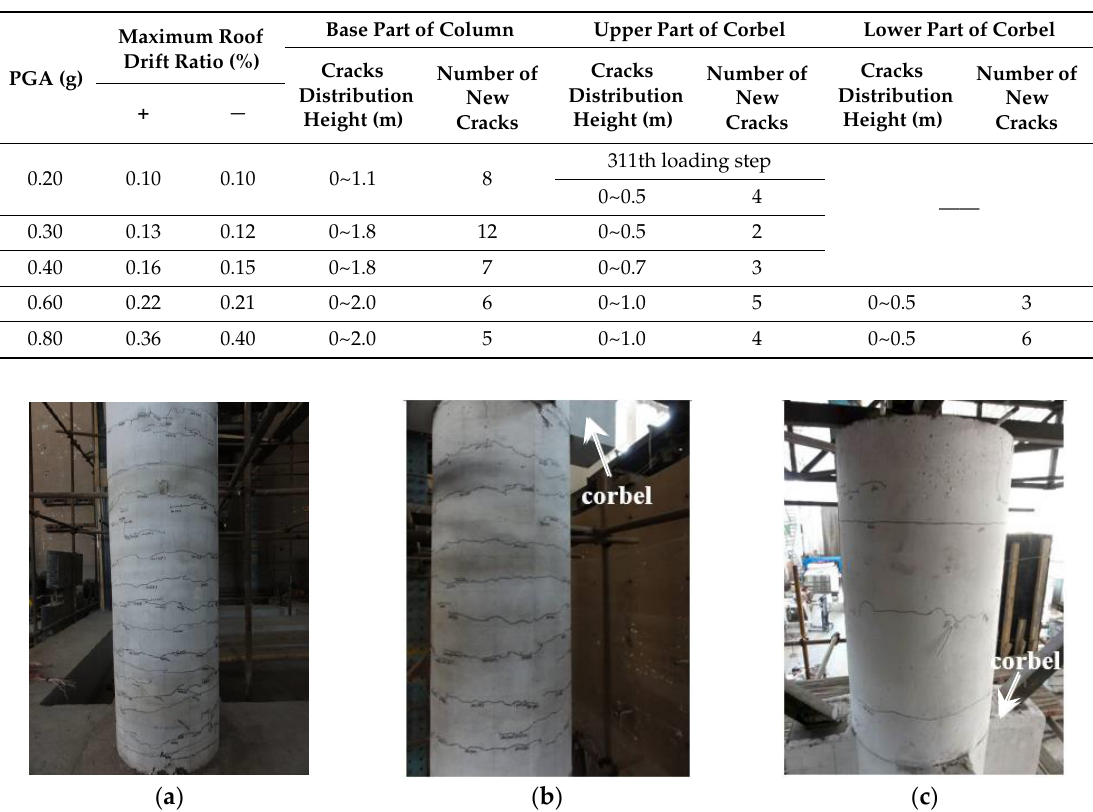
Figure 8. Measured strains versus base shear force of the steel truss and diagonal braces under the final loading case of PDTs with PGA of 0.80 g. Table 3. Cracking details of the column C1 under pseudo-dynamic tests (PDTs).